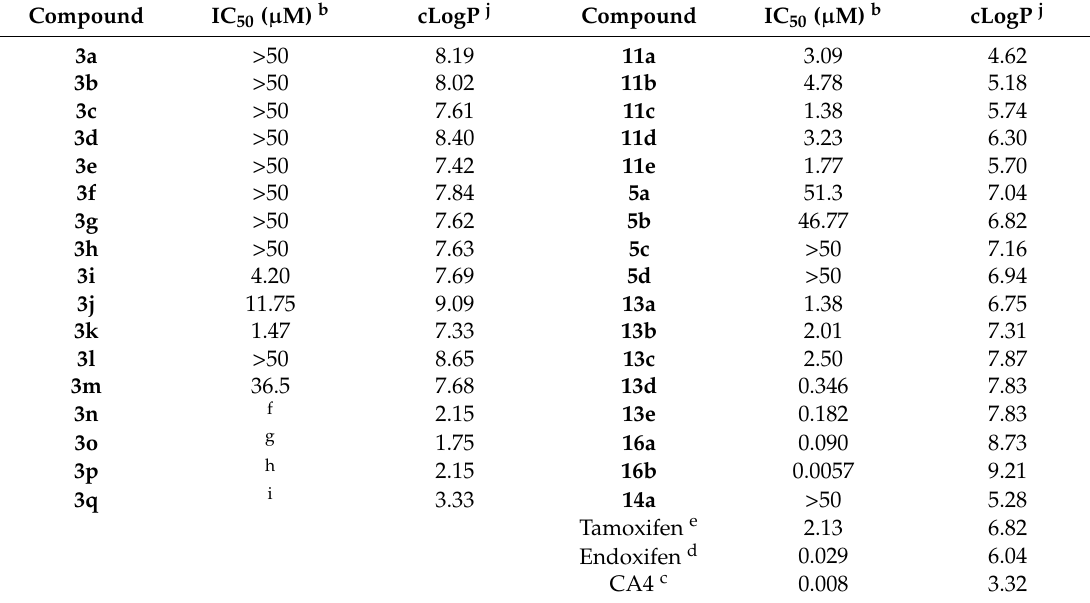
a Mean IC 50 values of compounds for their antiproliferative effects and percent cytotoxicity on a human MCF-7 breast cancer cell line. b IC 50 values are half maximal inhibitory concentrations required to block the growth stimulation of MCF-7 cells. Values are an average of at least three experiments performed in triplicate with typical standard errors below 15%. c The IC 50 value obtained for 14 (CA4) in this assay is 8 nM for MCF-7 and is in good agreement with the reported values for CA4 in MCF-7 cell line [61–63]. d The reported IC 50 value for endoxifen in the MCF-7 cell line is 50 nM [65]. e The IC 50 value for Tamoxifen is in agreement with the reported IC 50 value